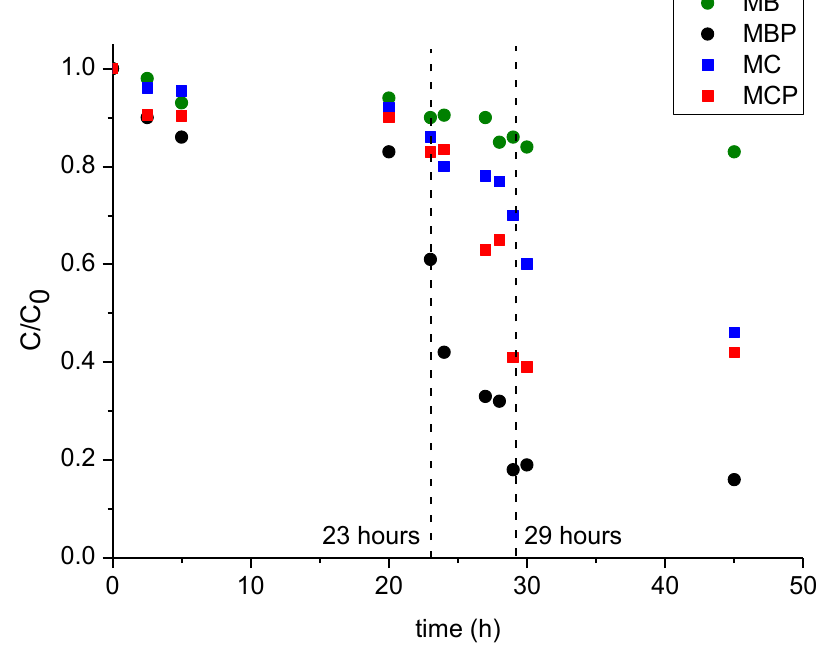
Figure 3. Kinetics of adsorption of DCF (C 0 = 20 mg L − 1 ) for the four magnetic materials. Data reported considering a final concentration of materials of 500 mg L − 1 and a final time of 45 h. Legend: MB (green circles), MBP (black circles), MC (blue squares), MCP (red squares). Vertical dotted lines evidenced the two additional steps of 200 mg L − 1 of materials at 23 and 29 h.